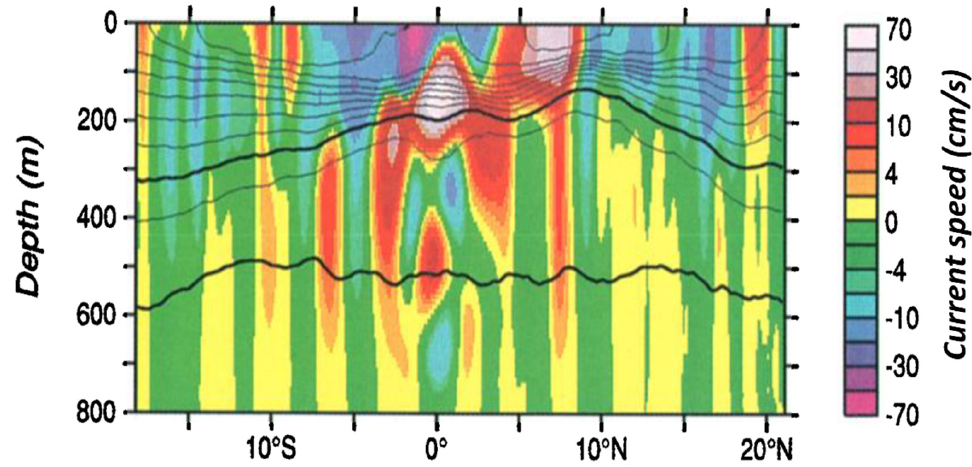
42 of 67 Figure 32. Sea clutter Doppler spectra computed from raw buoy measurements of wave spectra during the lifetime of a convective cell near Bathurst Island, Northern Australia. Noise in the buoy measurements is reflected in the Doppler spectra, but the transient and return to the pre-event state are unmistakable. Protecting against hazards is not the only way that skywave radar can assist ship- ping. We have mentioned that route planners try to take advantage of favourable ocean